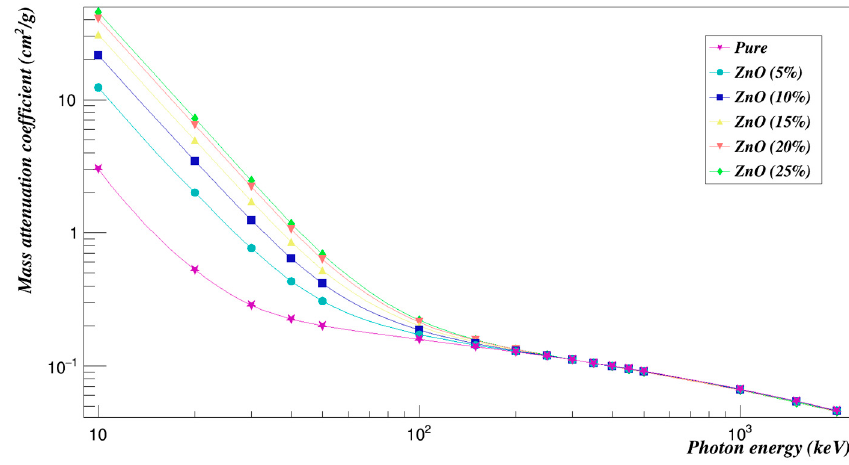
Figure 8. Photon mass attenuation coefficients of Polyimide doped with zinc oxide.